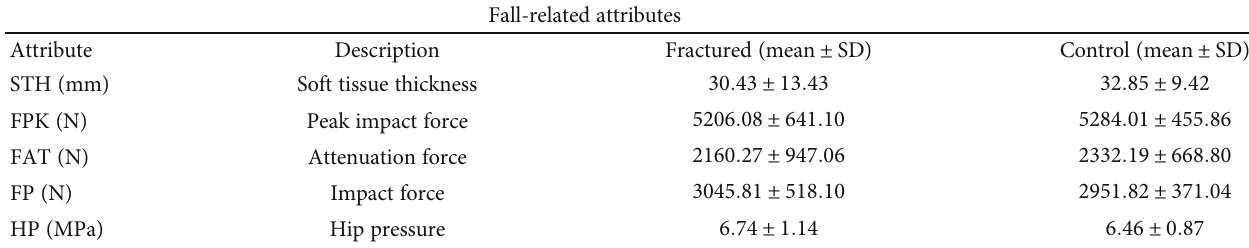
Table 3: Fall-related attributes.